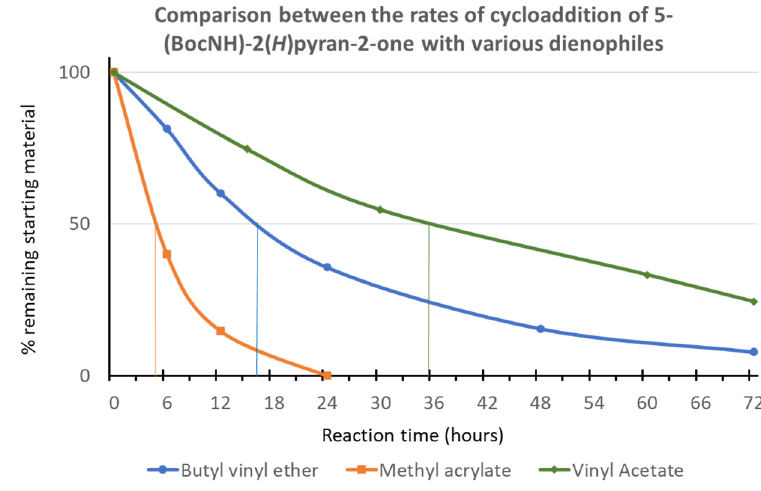
Figure 1. Comparison between the rates of cycloaddition of 8 with dienophiles at 100 °C. The faster rate of cycloaddition of 8 to methyl acrylate than to butyl vinyl ether, would be consistent with 5-(BocNH)-2( H )pyran-2-one acting as the diene partner in a normal electron demand cycloaddition with methyl acrylate.